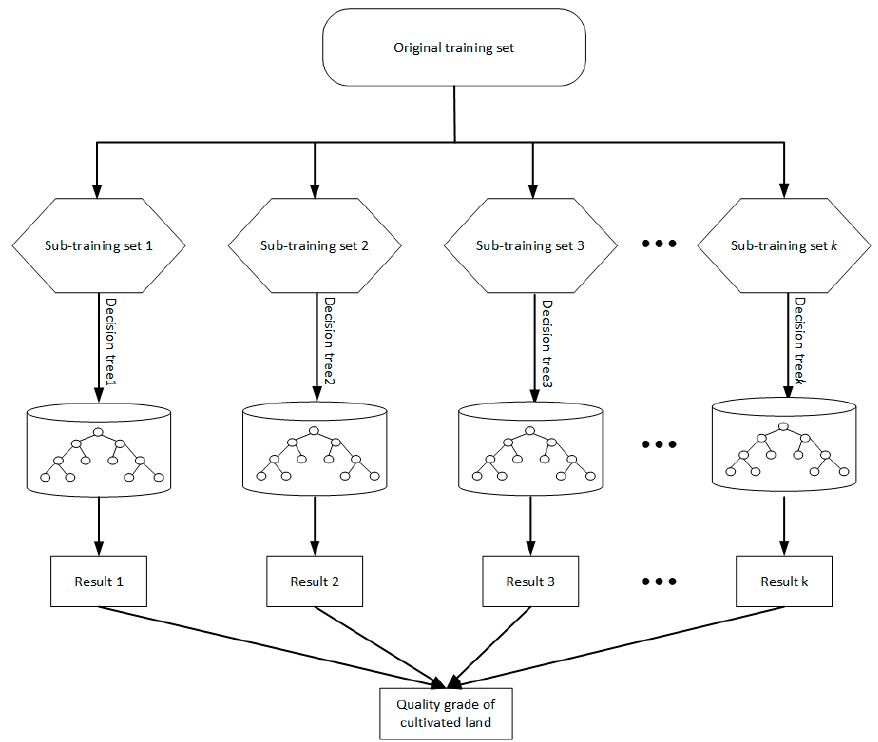
Figure 4. Fundamentals of random forest (RF) model construction for farmland quality.